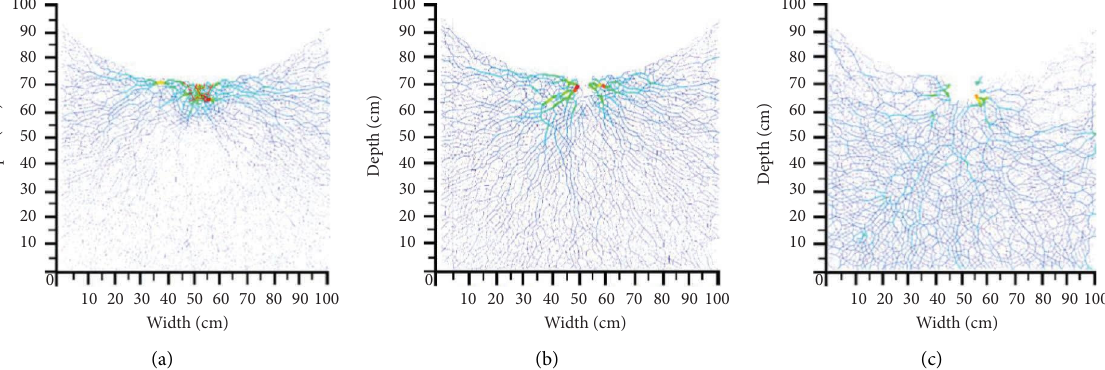
Figure 15: Contact chain distribution of base rock particles: (a) one month of operation; (b) two years of operation; (c) four years of